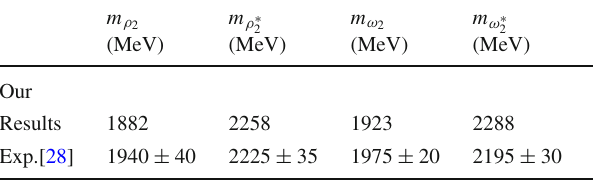
Table5 Massesoftheaxial-tensormesonsat T = 0andcomparisonof the numerical values with the prediction of “Regge Trajectory Model”